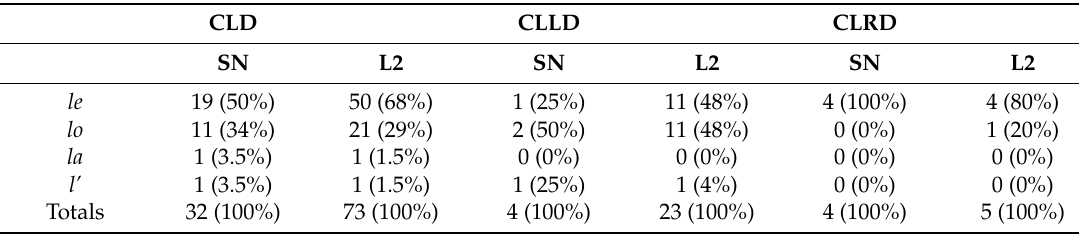
Table 6. Clitics according to clitic doubling